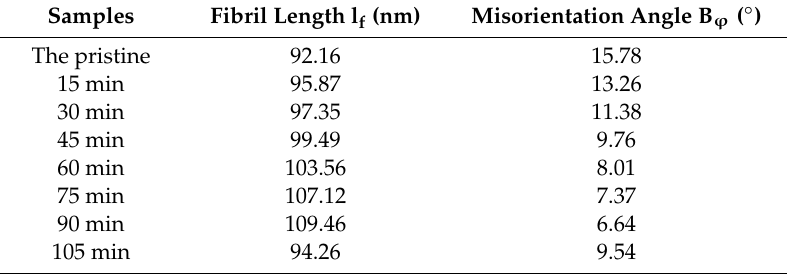
Table 1. The fibril length l f and misorientation angle B ϕ of the pristine and treated F-III fibers in Sc-CO 2 .